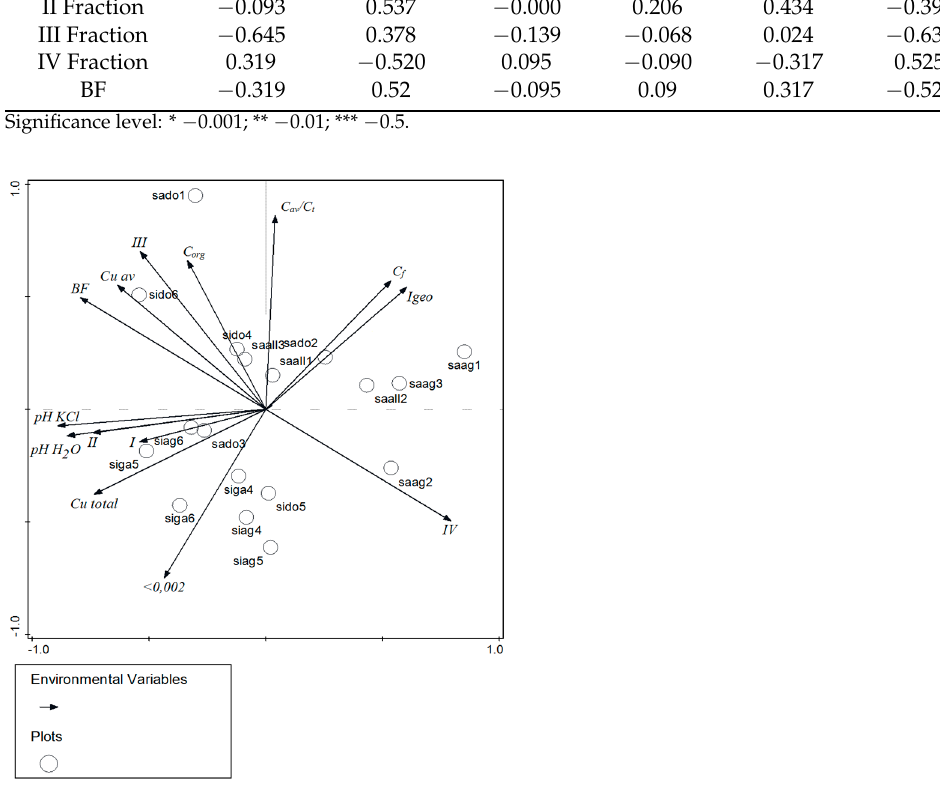
Table 4. Summary of the Cu results in PCA.